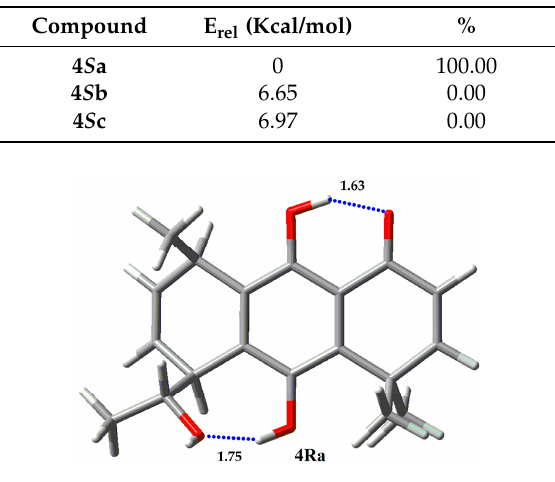
Figure 8. Single rotamer for 4 S . Table 5. Boltzmann population for rotamers of 4 S .